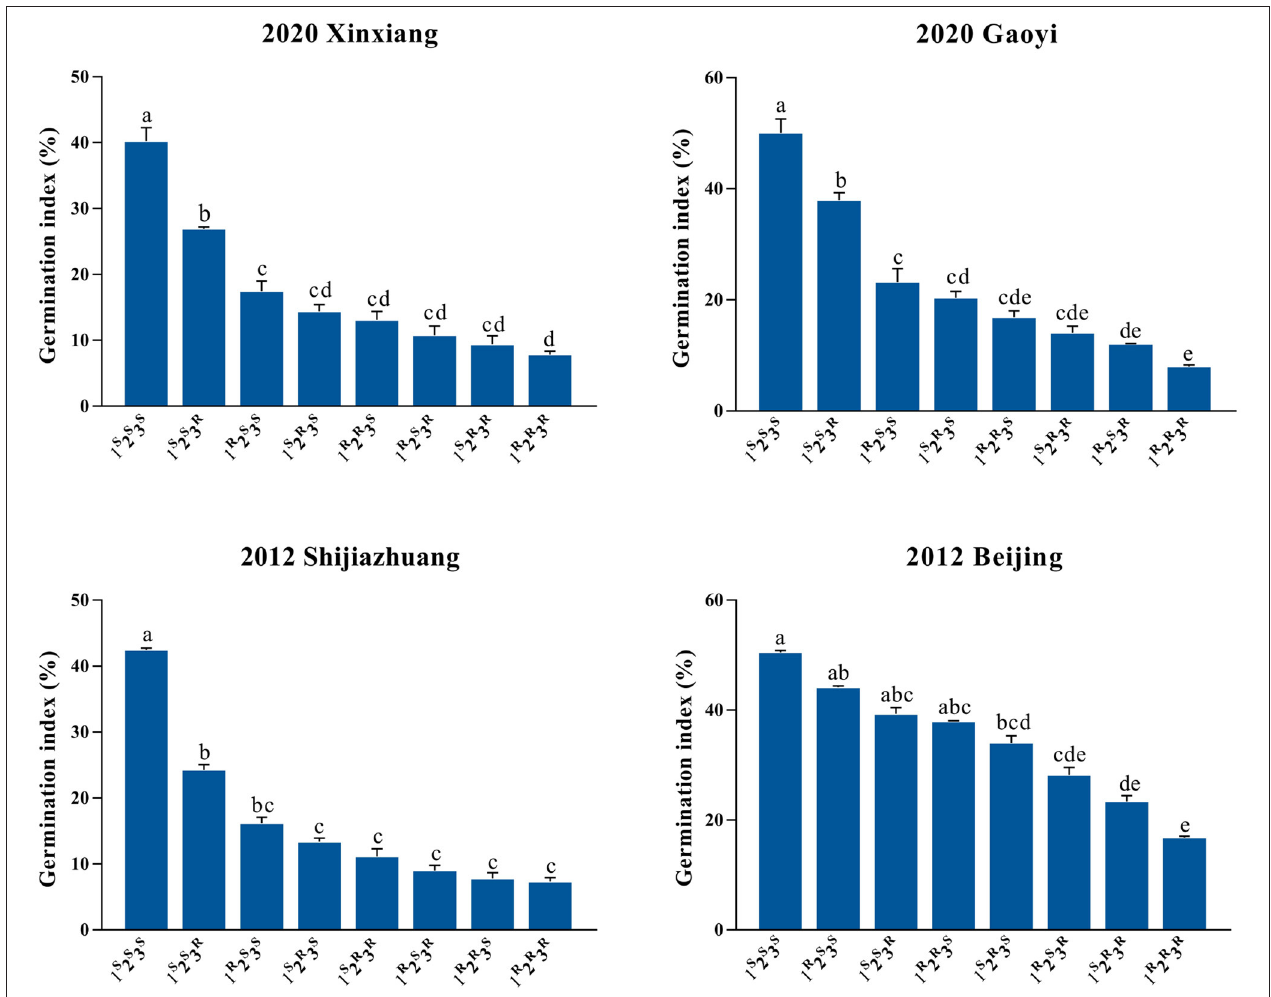
FIGURE 2 | Distributions of germination index (GI) among eight genotypic combinations of Qphs.caas-3AL , Qphs.caas-3DL , and Qphs.caas-4AL grown in four environments. The x -axis shows the genotypic groups, and the y -axis indicates GI (%). The numbers 1, 2, and 3 represent Qphs.caas-3AL , Qphs.caas-3DL , and Qphs.caas-4AL , respectively; the superscript letters R and S represent resistance and susceptible alleles, respectively. Genotypes with different letters indicate significant differences ( P < 0.05) in GI, and those with the same letters show no significant differences ( P > 0.05). Error bar, standard error of each group mean.